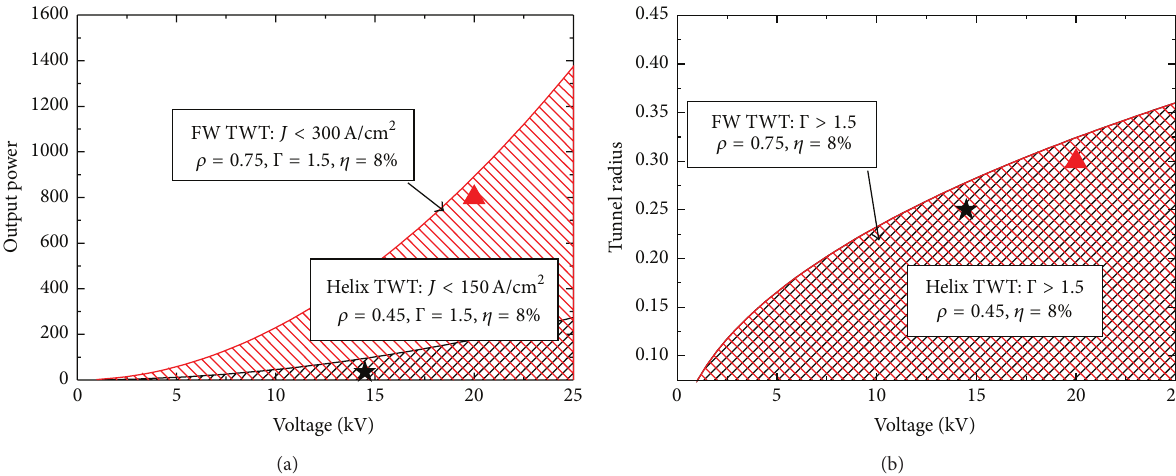
Figure 2: (a) Relationship between output power and voltage for helix TWT (black slashed region) and FWG TWT (red backslash region), which are partially overlapped. (b) Relationship between tunnel radius and voltage for helix TWT (black slash region) and FWG TWT (red backslash region), which are completely overlapped.